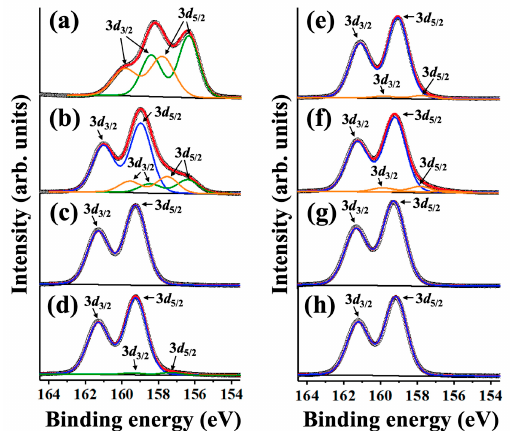
Figure 6. X-ray photoelectron spectroscopy (XPS) results: ( a ) Y 2 O 3 and ( e ) YF 3 before etching, ( b ) Y 2 O 3 and ( f ) YF 3 after etching of the powered electrode; ( c ) Y 2 O 3 and ( g ) YF 3 after etching of the grounded electrode; ( d ) Y 2 O 3 and ( h ) YF 3 after etching of the grounded wall.